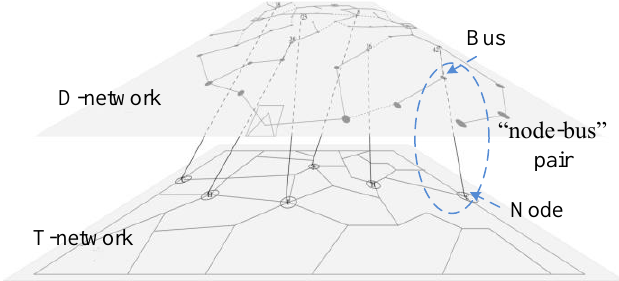
Figure 2. Geographically coupled networks.